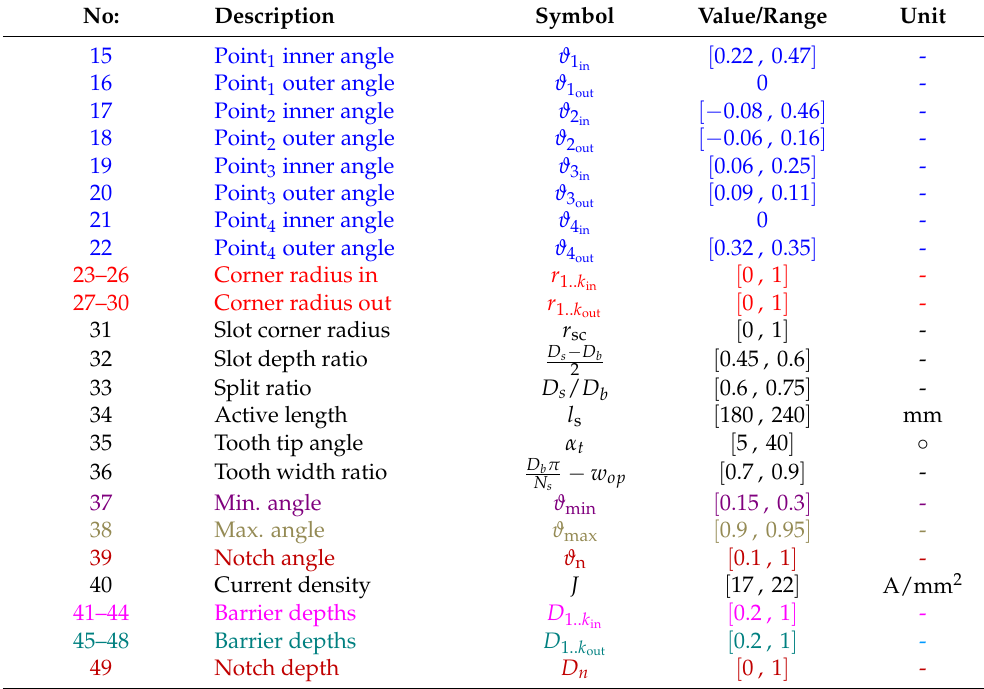
Table 4. List of optimization